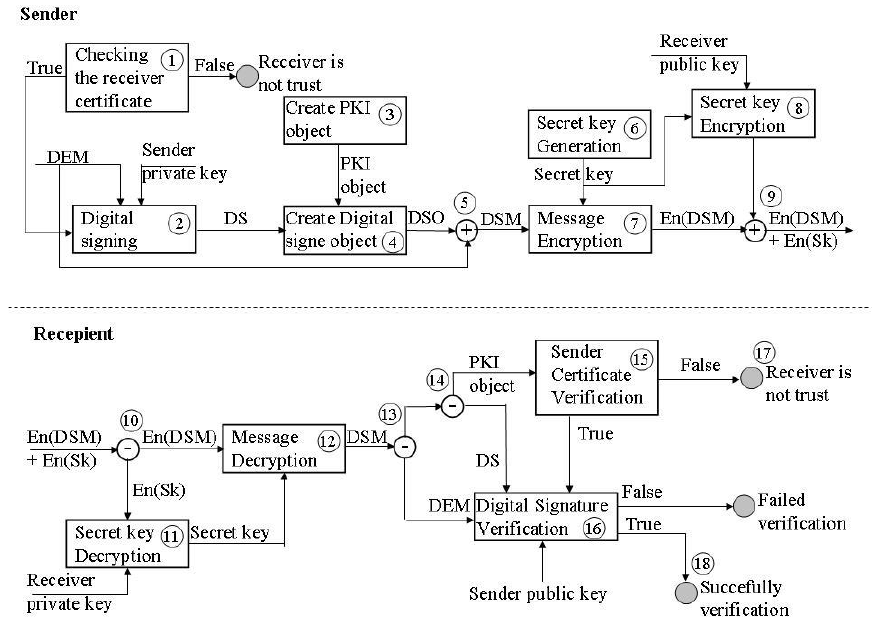
Figure 3. Model for securing the transfer of non-repudiated and protected DEM data.